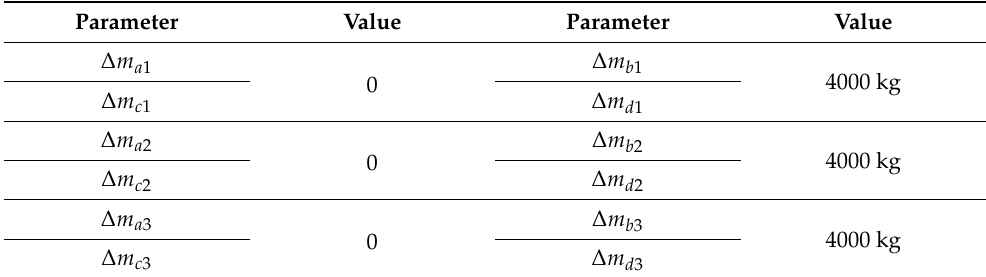
Figure 30. Flow chart of fast calculation method for optimal matching of bending moment in biaxial fatigue test based on PSO. Table 1. Parameter